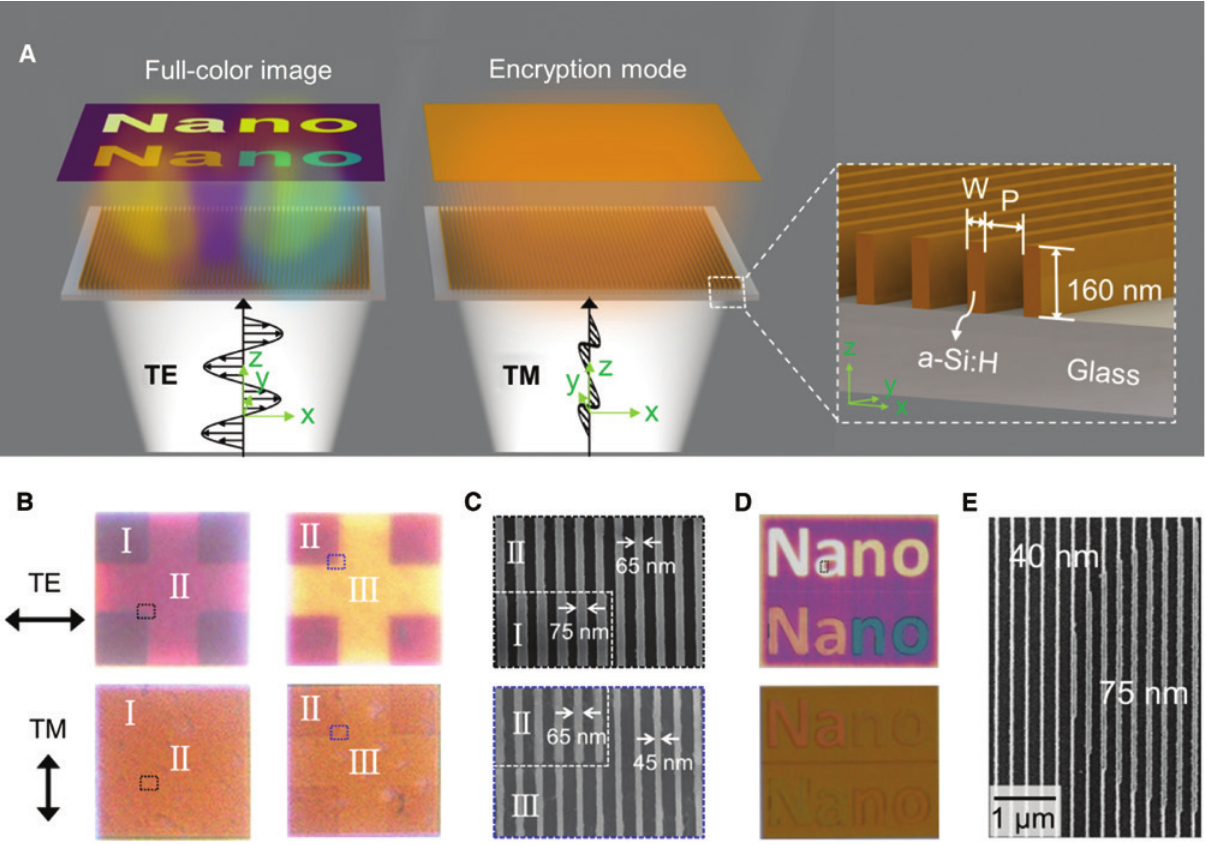
Figure 1: Concept and experimental demonstration of the proposed polarization-encrypted color pixels. (A) The schematic of the proposed polarization-encrypted color pixels under the TE and TM polarized illuminations. The color pixels based on an array of a-Si:H NGs are capable of enabling full-color images under the TE polarized illumination and encrypting the image by rendering invariable orange color under the TM polarized illumination. The width and period of the NGs are denoted by W and P, respectively. The height of NGs is fixed at 160 nm. (B) The bright-field microscope images of the manufactured microscopic cross images (30 μ m × 30 μ m) under the TE and TM polarized illuminations. Regions of I, II and III represent the NGs with different widths of 75, 65 and 45 nm. (C) The corresponding SEM images at the corner of the cross, marked by the black and blue dotted boxes in (B). (D) Bright-field microscope images of the manufactured microscopic “NanoNano” images (100 μ m × 85 μ m) under the TE and TM polarized illuminations. (E) Corresponding SEM images of the region marked by the black dotted boxes in